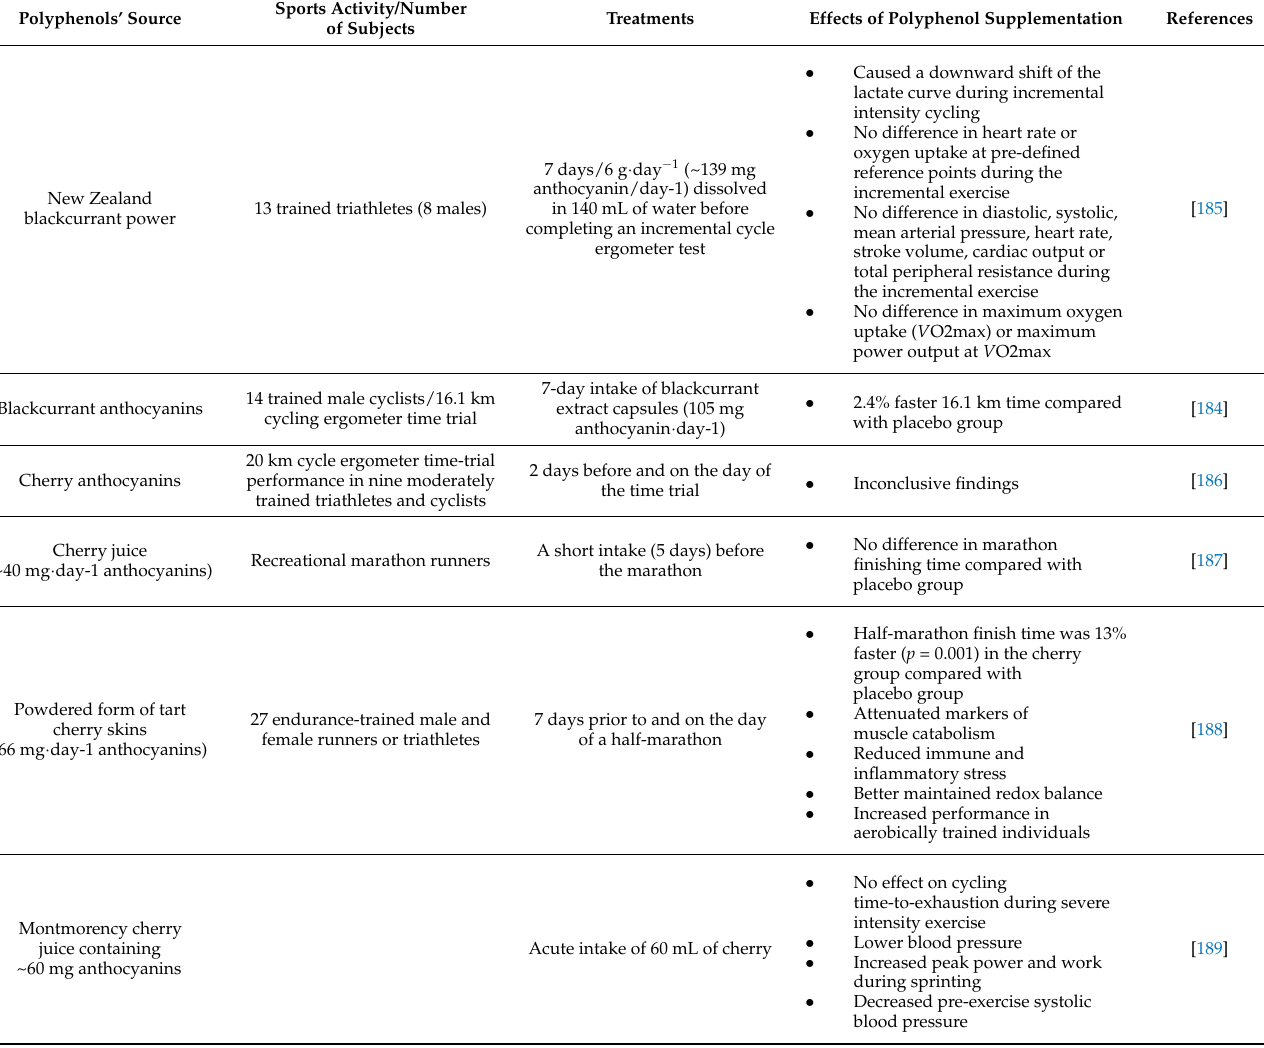
Table 4. The effects of polyphenol supplementation from different sources on exercise